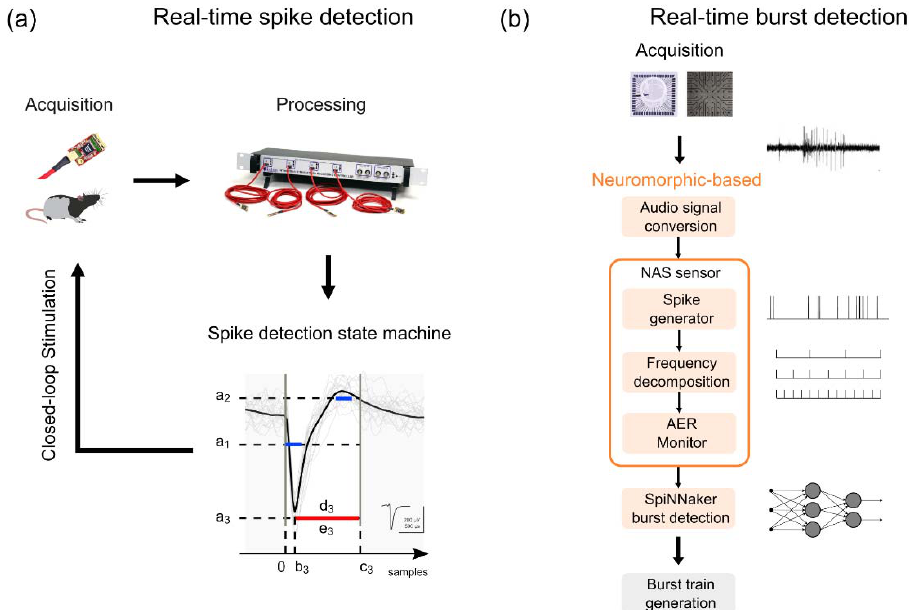
Figure 6. Overview of the methodological approaches. ( a ) Closed-loop system schematization to perform activity-dependent stimulation (ADS). The blue lines are the inclusive threshold, while the red line is exclusive. The length of the blue and red segments represents the time duration of a threshold limited by the onset sample b i and the end sample c i . The algorithm identifies as a spike a waveform characterized by an absolute value of its negative peak greater than a1 during b 1 – c 1 and that does not exceed a 3 during b 3 – c 3 , while the absolute value of its positive peak must exceed the threshold a 2 during b 2 – c 2 . Modified from [95]. ( b ) Neuromorphic-based burst detection scheme. The conversion of the neuronal signal into audio allows for executing the frequency band decomposition in order to prepare the input for the SpiNNaker module to discriminate between bursting and non-bursting activity. Modified from